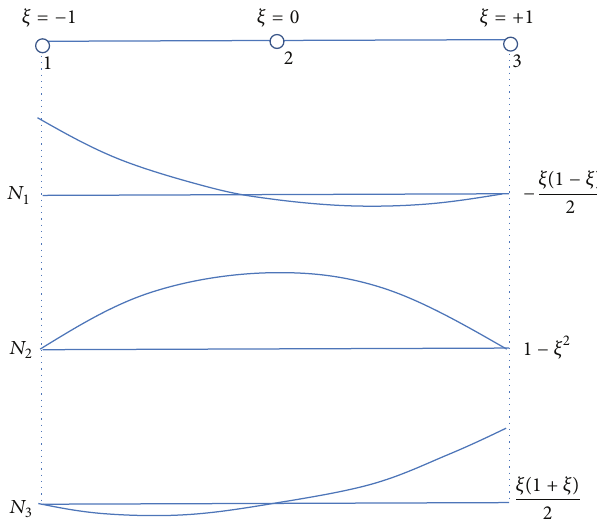
Figure 2: Typical quadratic interpolation for frame